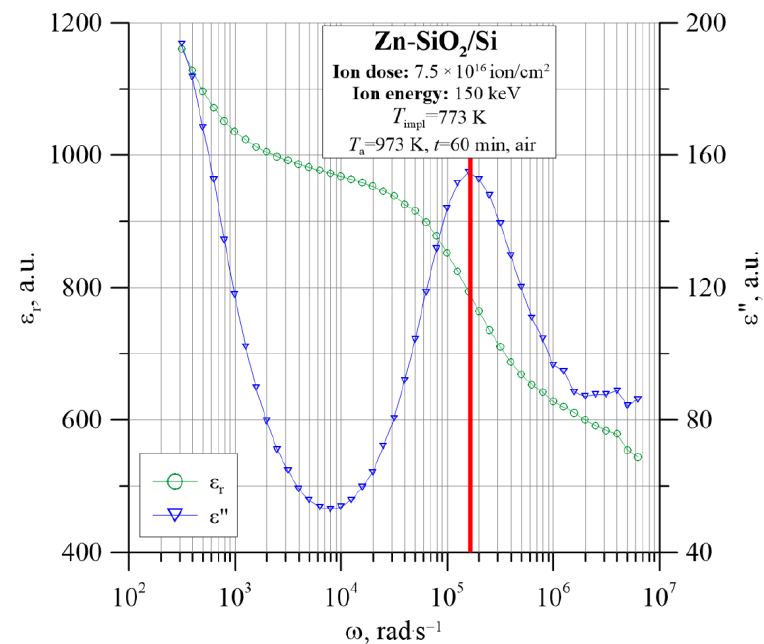
Figure 14. Comparison of the real and imaginary dielectric permittivity as a function of frequency measured at T p = 333 K.